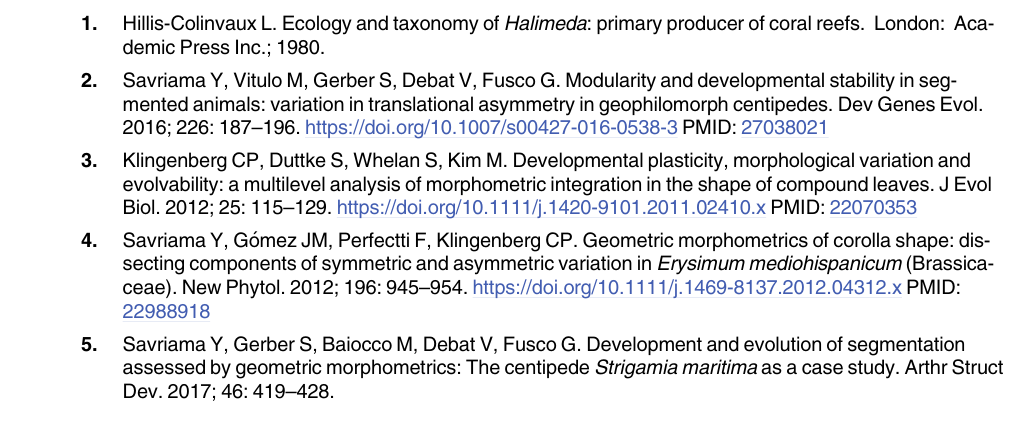
S5 Table. Linear correlation analyses among the MS obtained for the individual compo- nents of symmetry and asymmetry at the level of individual plants. S6 Table. Multivariate Procrustes ANOVA models based on the configurations obtained from unslid equidistant semilandmarks, which decomposed symmetric variation and the components of asymmetry at the level of individual